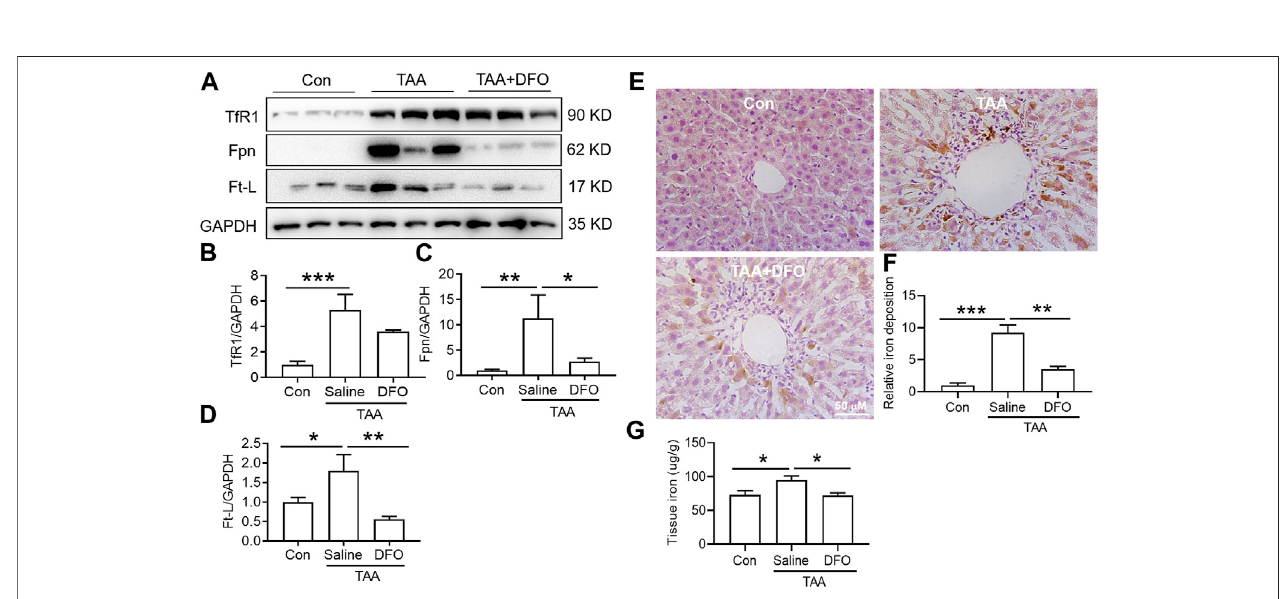
FIGURE 5 | Effects of DFO on iron-related protein expression and iron content in TAA-induced ALI mice. (A) Western blotting analysis of TfR1, Fpn and Ft-L expression in the livers of mice with different treatments. (B – D) Relative protein exprssion of TfR1, Fpn and Ft-L in (A) (E) DFO suppressed the increase in positive centrolobular iron deposition induced by TAA. (F) Semiquantitative iron levels of the mice liver in (E) (G) Iron content detection in the livers of mice with different treatments. All data are presented as the mean ± SEM ( n = 6-9 mice per group); * p < 0.05, ** p < 0.01, and *** p < 0.001 versus the indicated group.